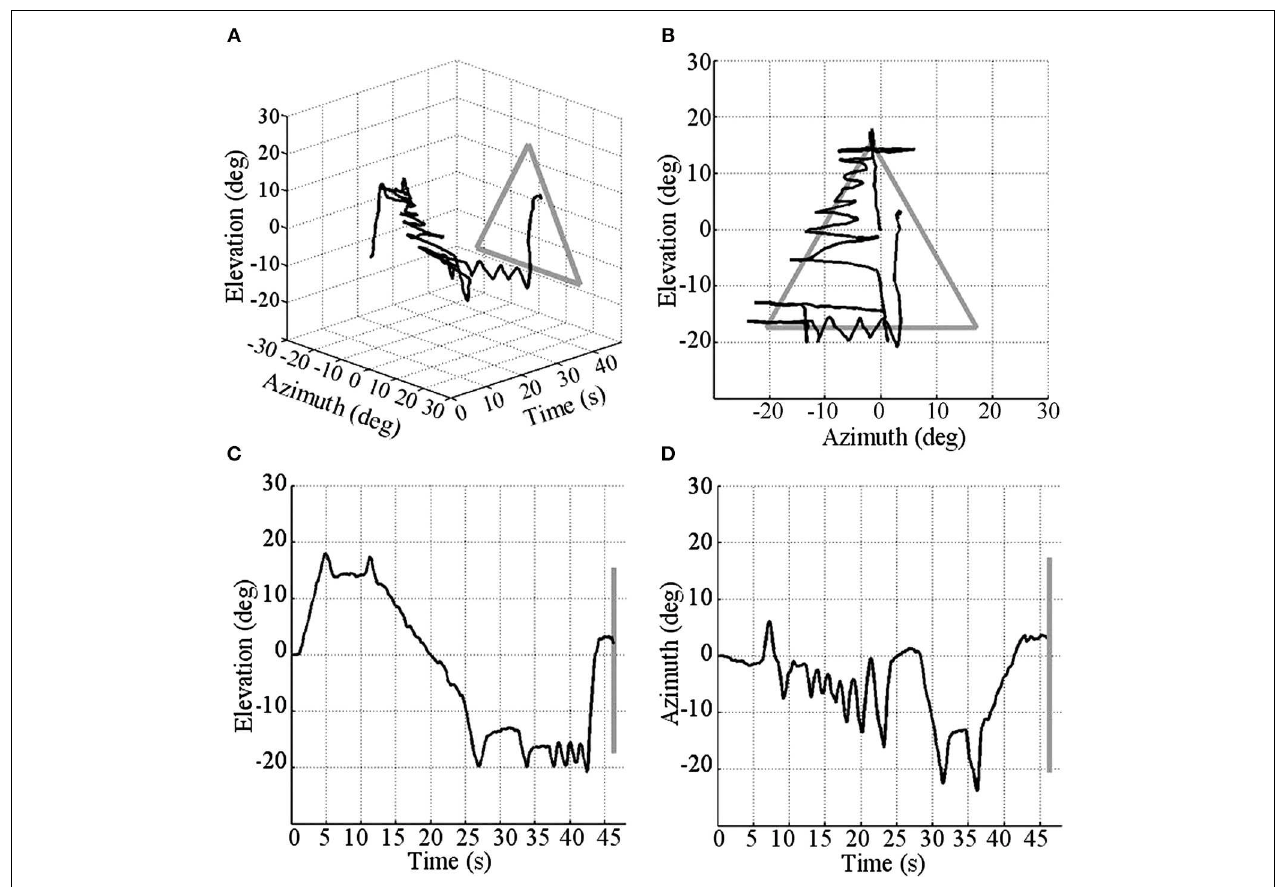
FIGURE 2 | Perceptual trajectory performed by a participant to recognize a triangle. In dark gray: perceptual trajectory; in light gray: the geometrical shape. (A) 3-D view (elevation, azimuth and time); (B) front view (elevation and azimuth); (C) side view (elevation and time); and (D) top view (azimuth and time).